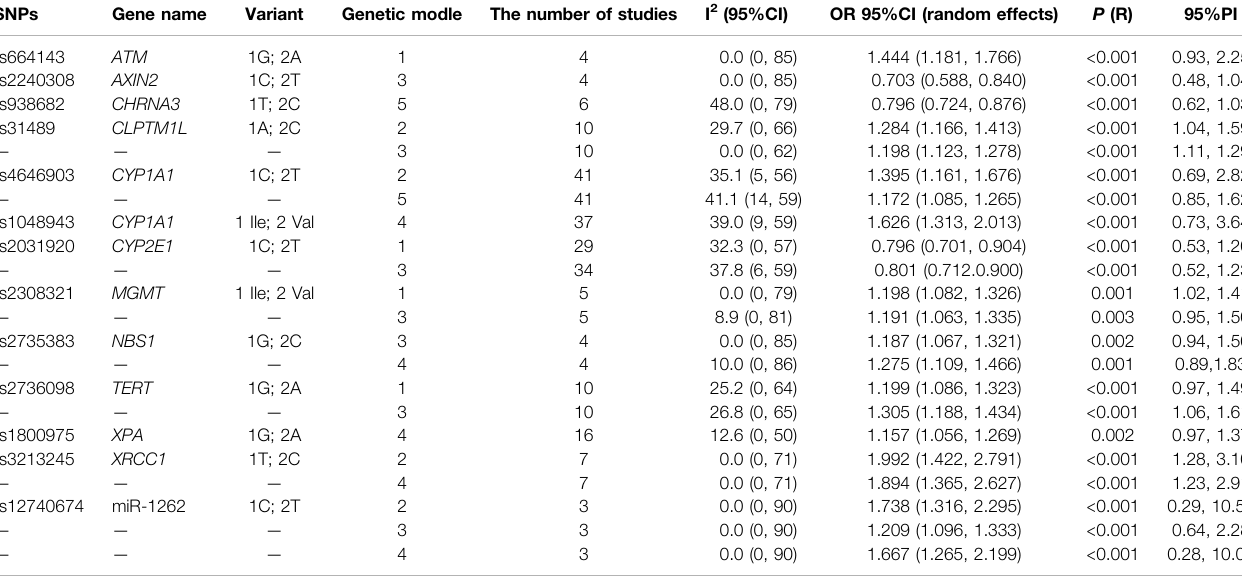
TABLE 2 | Meta-analysis results of SNPs with the strong cumulative evidence based on the Venice criteria and FPRP.